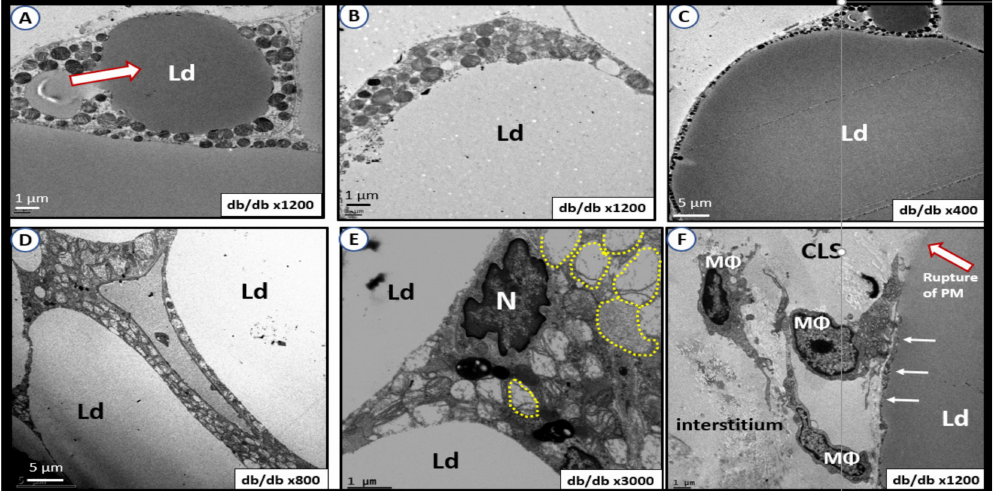
Figure 25. Brown adipose tissue (BAT) in controls to transdifferentiated white adipose tissue (WAT) in obese, insulin resistant, diabetic db/db models. Panels A – F depict the gradual and continuous deposition of lipids in the form of triglycerides into the lipid droplet(s) (Ld) of the transdifferentiated engorged WAT adipocytes in the db/db . Note how the mitochondria (Mt) become pushed to the outer rim of the Ld and become smaller as in the progression from panels A – C . In panels D and E note the aberrant mitochondria (aMt). Panels D and E depict the hyperlucent aberrant Mt with decreased electron density of the Mt matrix and attenuation and/or loss of crista (outlined by yellow dashed lines) in panel E . In panel F note that the plasma membrane is thinned (closed white arrows) to the point of rupture (open arrow outlined in red) with the release of toxic free fatty acids into the interstitium and the resulting recruitment of inflammatory macrophages (M Φ ) to form crown-like structures (CLS). These figures are provided with permission from the experiment in reference [69]. Magnifications and Scale bars vary. Ld = lipid droplet ; N = nucleus ; PM = plasma membrane